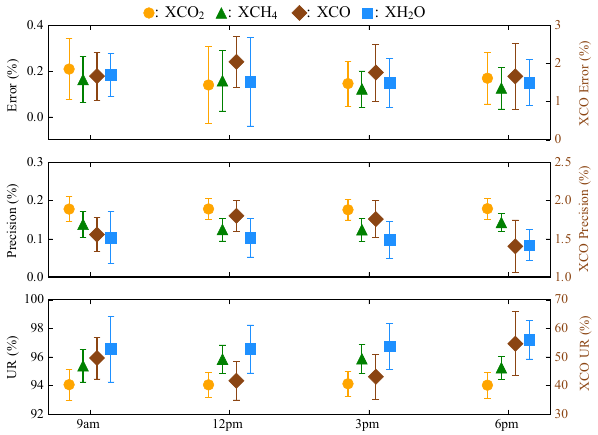
Figure 7. Average retrieval biases, precisions, and uncertainty re- ductions (URs) for simulated clear-sky retrievals at different times of day (LT). SNR is 300 and spectral resolution is 0.25cm − 1 . The a priori is biased 3% from the truth and has a 3% uncertainty. The error bars are the standard deviations of retrieval results from all the test cases. Note that the scales for XCO 2 , XCH 4 , and XH 2 O are on the left-hand side whereas those for XCO are on the right-hand